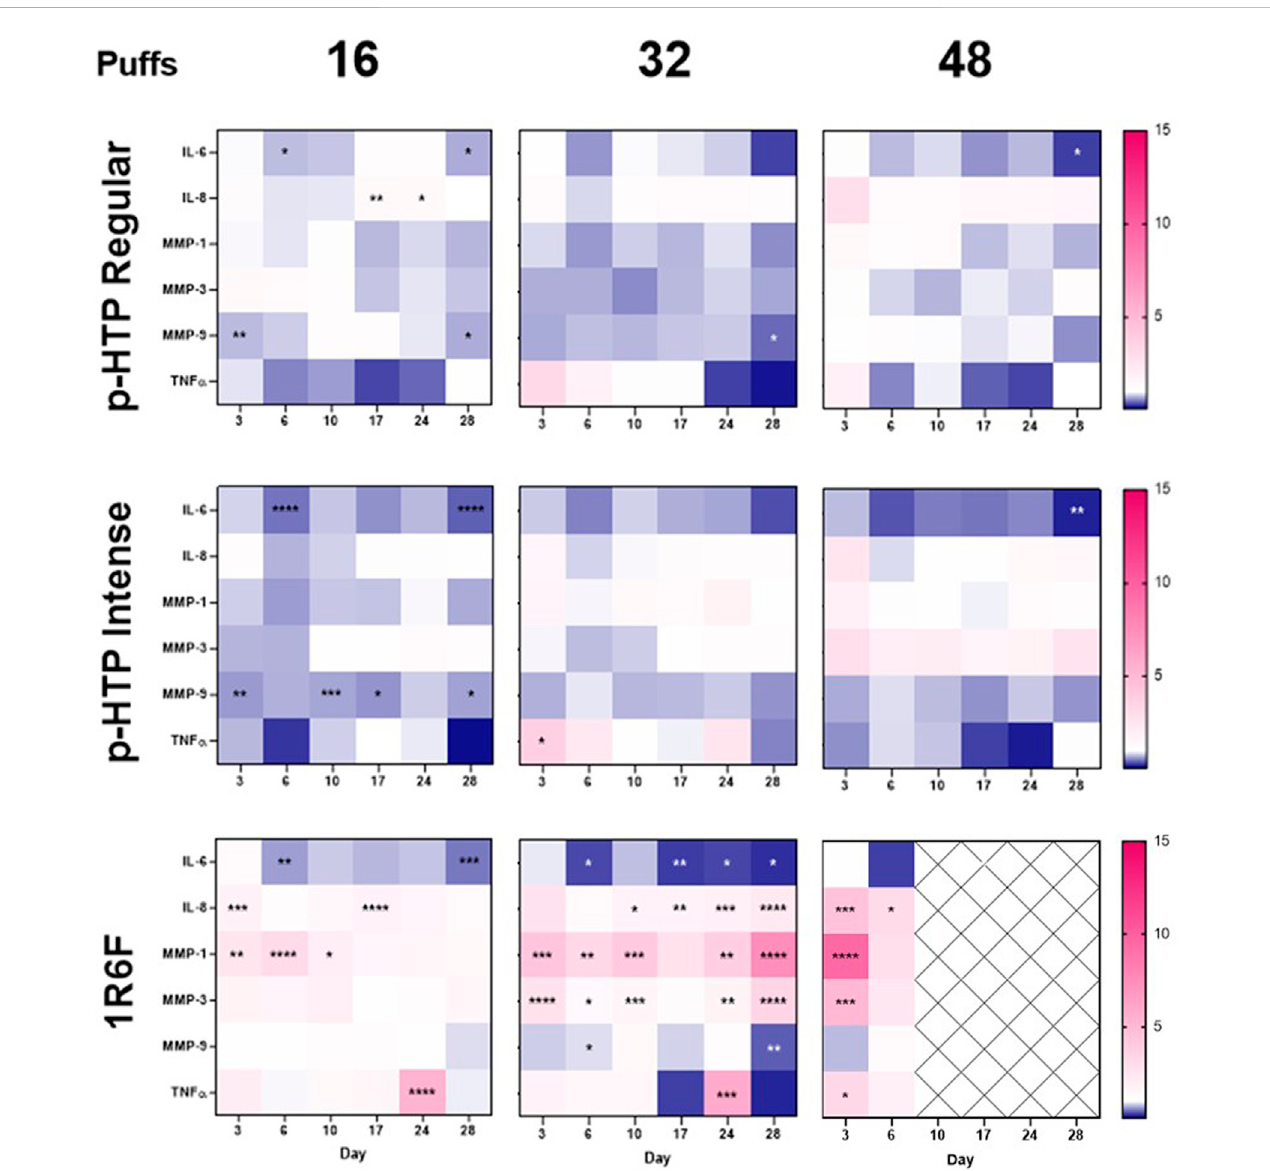
FIGURE 5 Heatmaprepresentationofin fl ammatorymarkersinthecellculturemediumofmodelsexposedto16,32or48puffsofp-HTPRegularorIntenseaerosol or 1R6F smoke. Cells were exposed according to the regime detailed in Figure 1 and levels in basal medium samples taken pre-exposure on days 3, 6, 10, 17, 24 and 28 are shown. Data is plotted as fold-change relative to Sham (1-fold); the highest value on the heatmap is set to the highest observed fold-change across the six markersmeasured (15-fold) and the lowest value isset to theequivalentinverse.Pink indicates an increase in secretion ofmarkersinto the medium compared to Sham levels, and blue indicates a decrease; crossed out cells indicate timepoints where signi fi cant cytotoxicity was fi rst observed for 1R6F.Statisticallysigni fi cantchangesfromShamlevelsaredenotedbyasterisks(*):* p ≤ 0.05;** p ≤ 0.005;*** p ≤ 0.001;**** p ≤ 0.0001(two-wayANOVAwith Dunnett ’ s post-hoc test). Data plots can also be found in the supplementary information (Supplementary Figures S5 – S10), along with measurements from samples taken 4 h post-exposure. n =